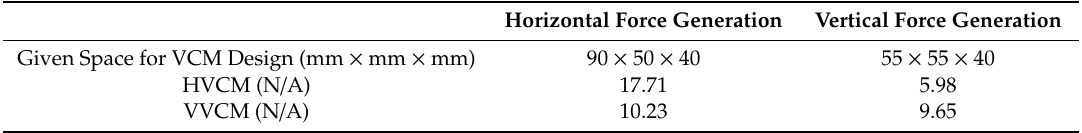
Table 5. Comparison of force constant for each optimized design